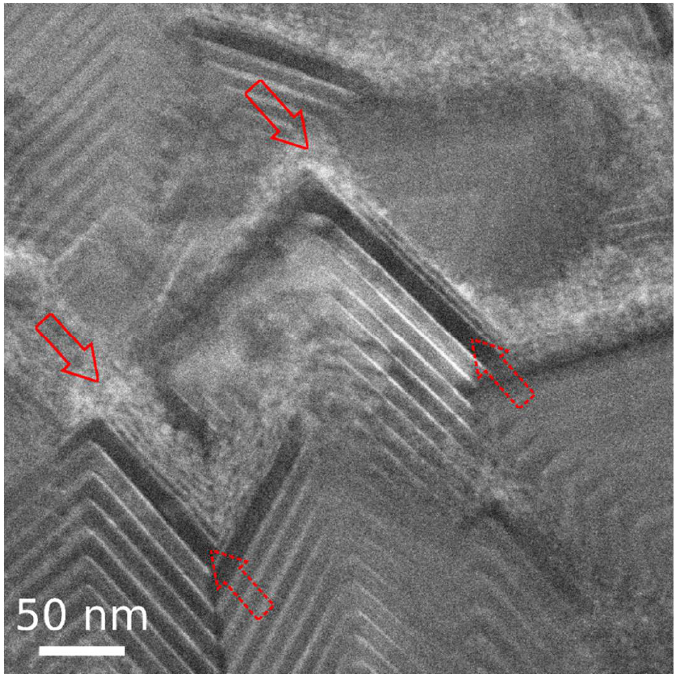
Figure 6. HAADF STEM micrograph from a representative cubic Al x Ti 1− x N grain. The dashed out- line arrows indicate the terminating hexagonal Al-rich layers (cf. Figure 5 and 6) and the solid outline arrows show polycrystalline regions rich in Cl (cf. Figure 5).